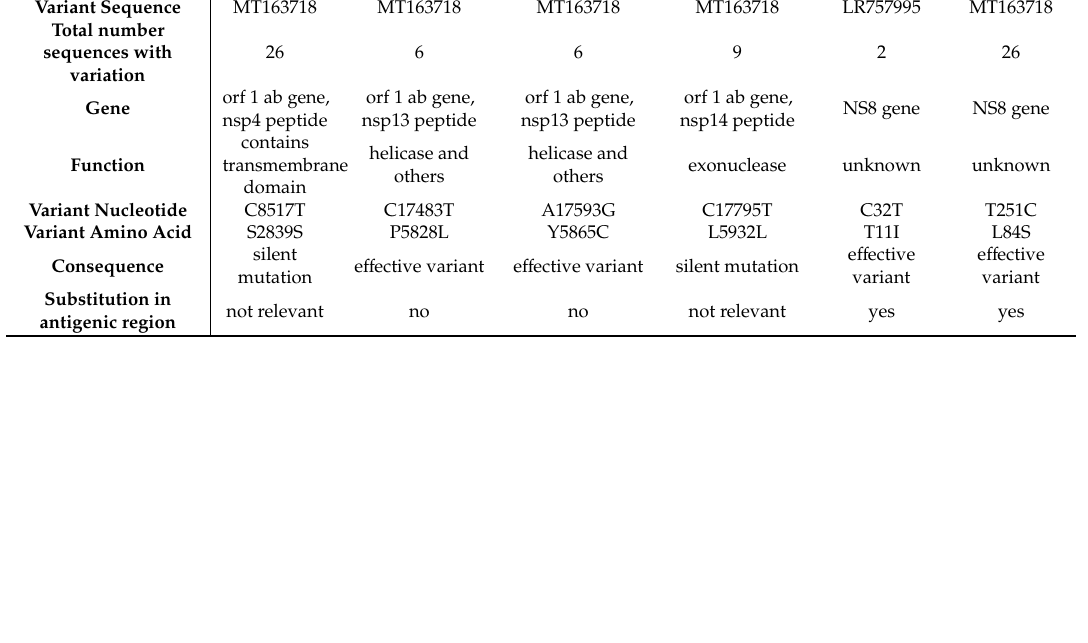
Table 1. Selection of 6 regions with base substitutions; variants are coded as initial base / amino acid-position after startcodon-base substitution; reference sequence for all analyses: MT159713. Selected